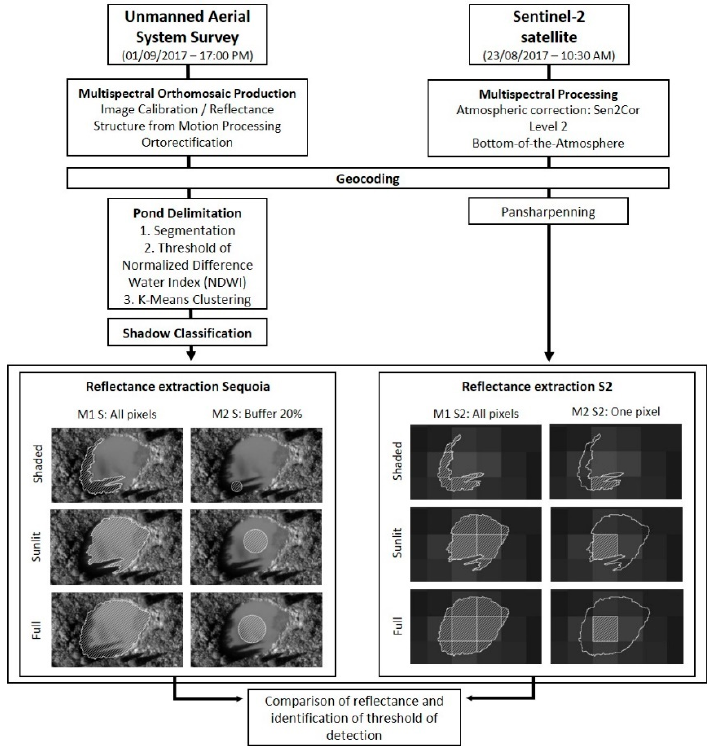
Figure 3. Methodological approach for the comparison of waterbody reflectance data from the UAS survey and S2 imagery.